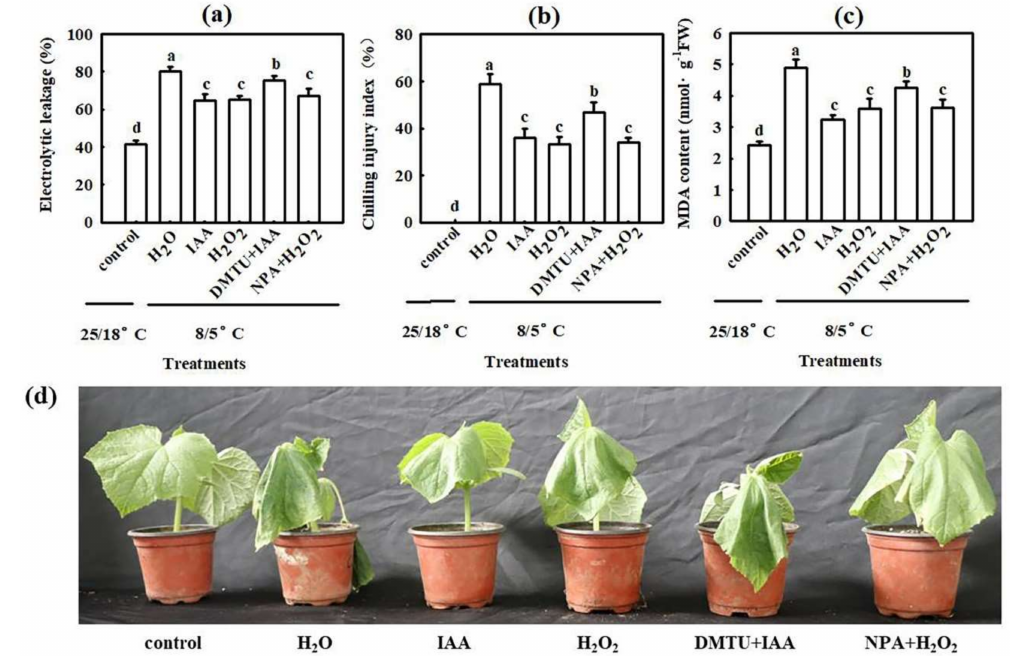
Figure 3. Interactive effects of IAA and H 2 O 2 on the chilling tolerance of cucumber seedlings. Cucumber seedlings were pretreated with 75 µ M IAA, 1.0 mM H 2 O 2 , 5.0 mM DMTU + 75 µ M IAA, 50 µ M NPA +1.0 mM H 2 O 2 , or deionized water (control) for 24 h and subsequently were exposed to chilling (8/5 ◦ C, day/night). ( a ) EL of seedlings before (control) and after chilling stress for 48 h. ( b ) CI of seedlings before (control) and after chilling stress for 72 h. ( c ) MDA content of seedlings before (control) and after chilling stress for 48 h; ( d ) Phenotype characterization of different treatments before (control) and after chilling stress for 48 h. Deionized water-treated seedlings before chilling stress were used as the control. The experiments were repeated three times with similar results. A typical picture is shown here. The data represent the mean ± SD of three biological replicates. Different letters indicate significant differences ( p < 0.05), according to Duncan’s new multiple range